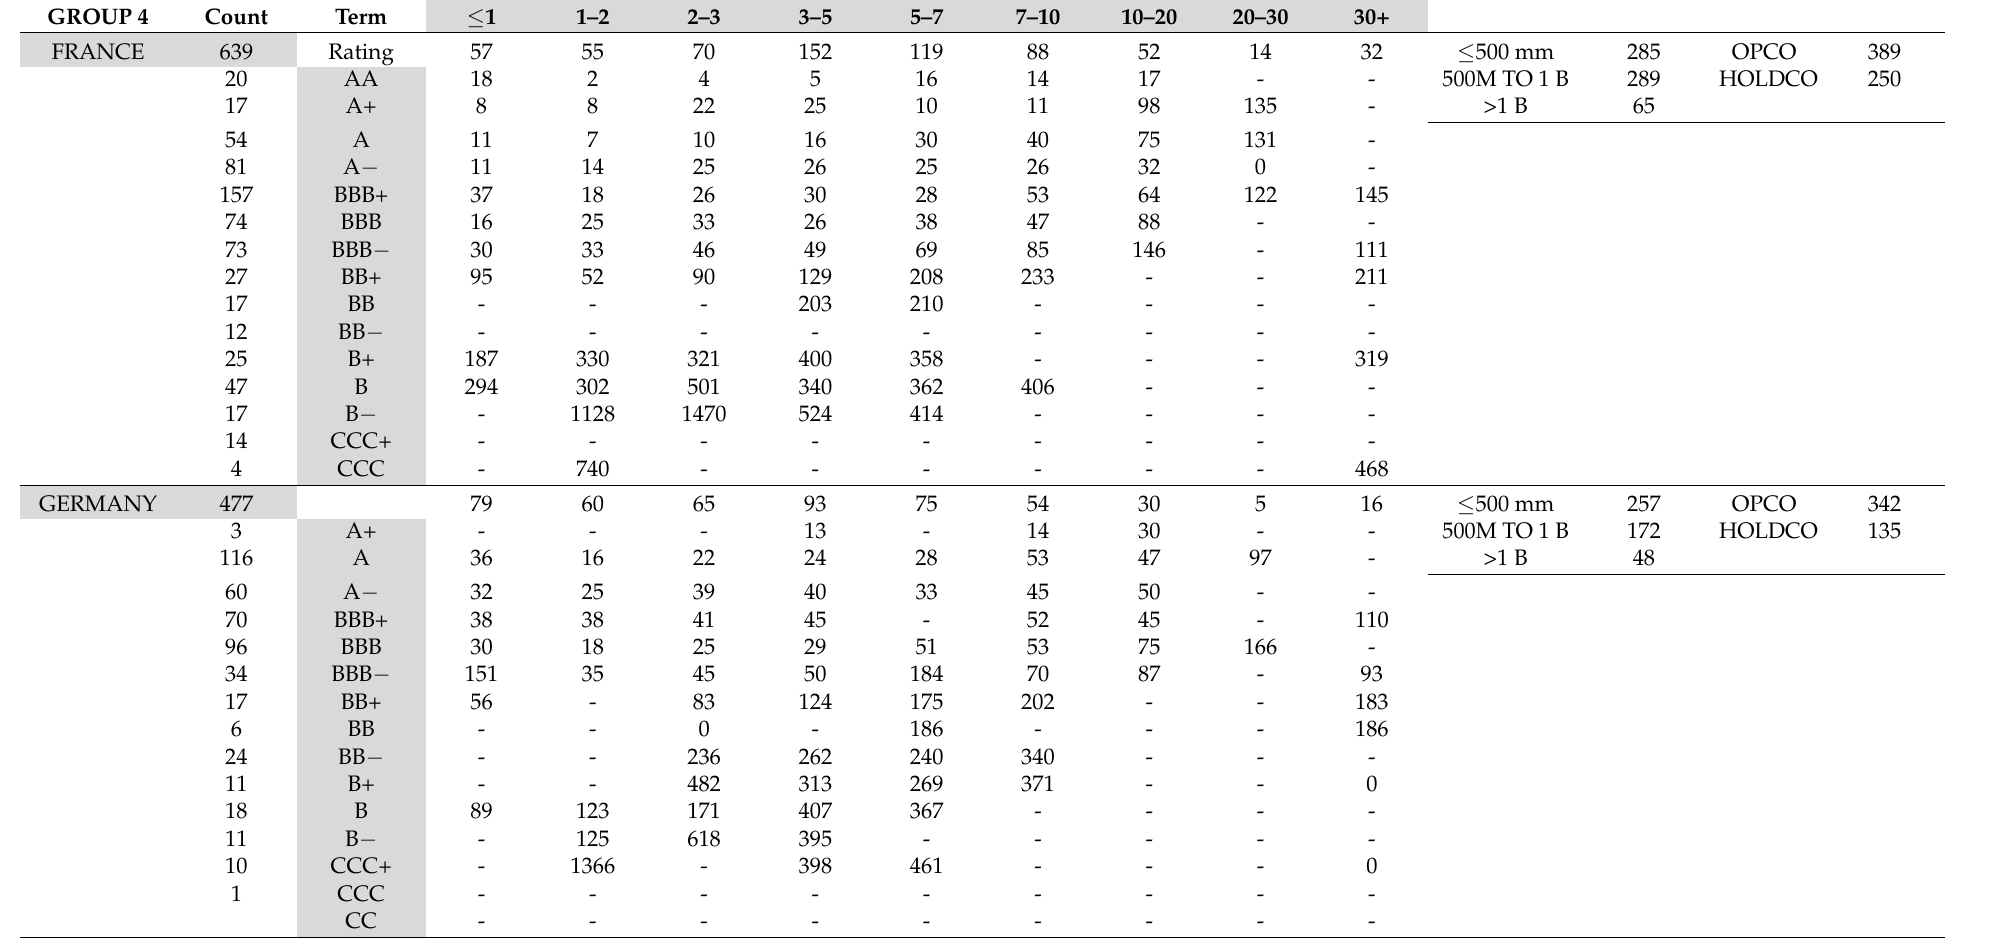
Table 6. G20—Group 4—Corporate credit spreads with S&P ratings and terms to maturity, issue amount, and the business structure of the issuer. Adding